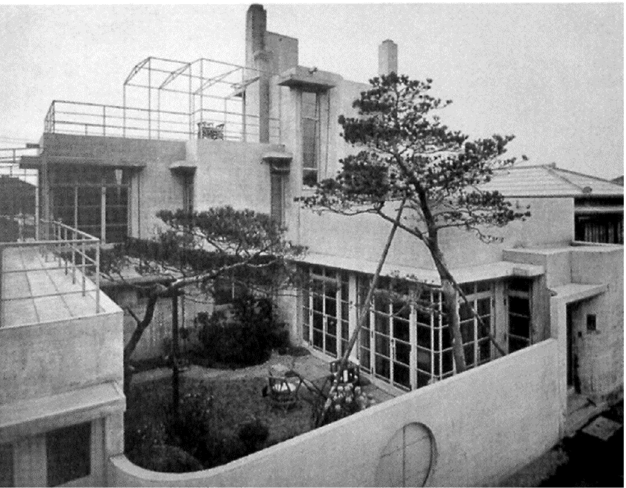
Figure 2. Raymond’s own Reinanzaka House in Tokyo, entirely realized in monolithic reinforced concrete, 1923. Source: authors. concrete, 1923. Source: